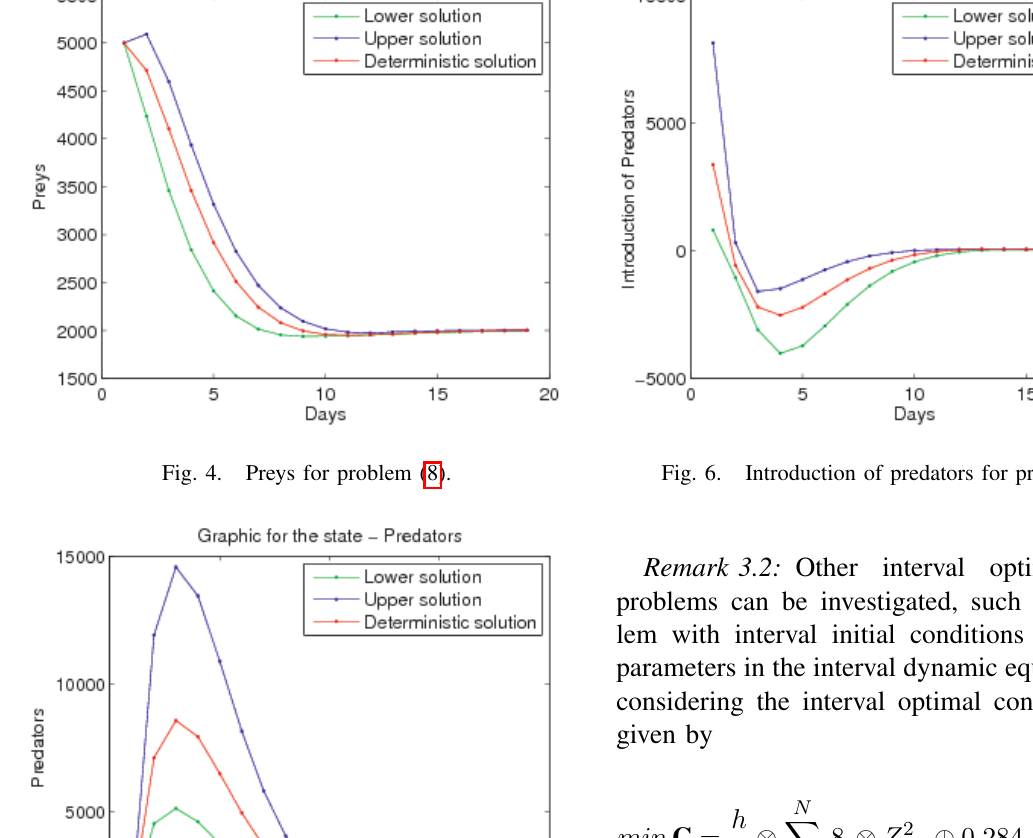
Fig. 4. Preys for problem (8).